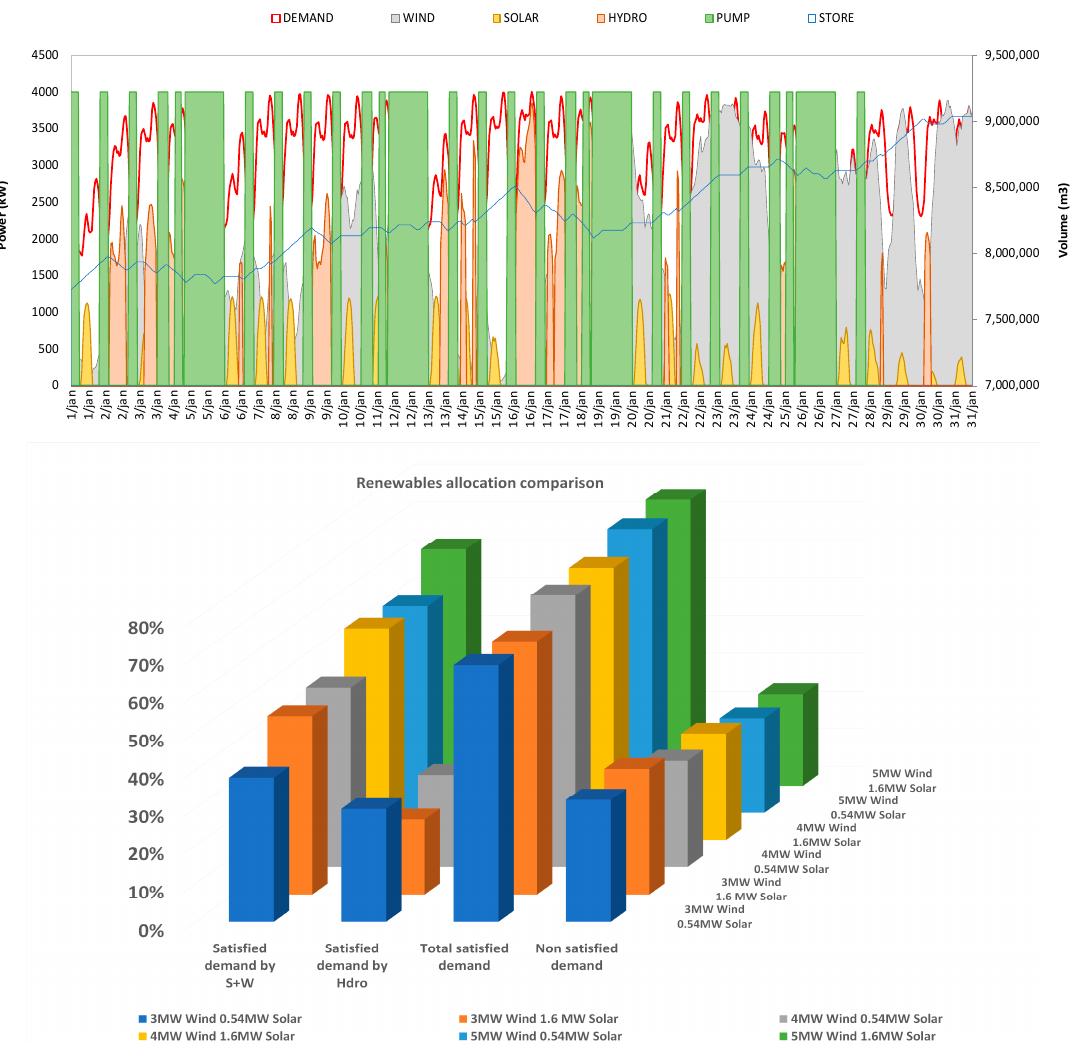
Figure 3. Energy contribution of each renewable source to satisfy the demand for different installed powers: power variation ( top ); satisfaction percentage for different power solutions ( bottom ).